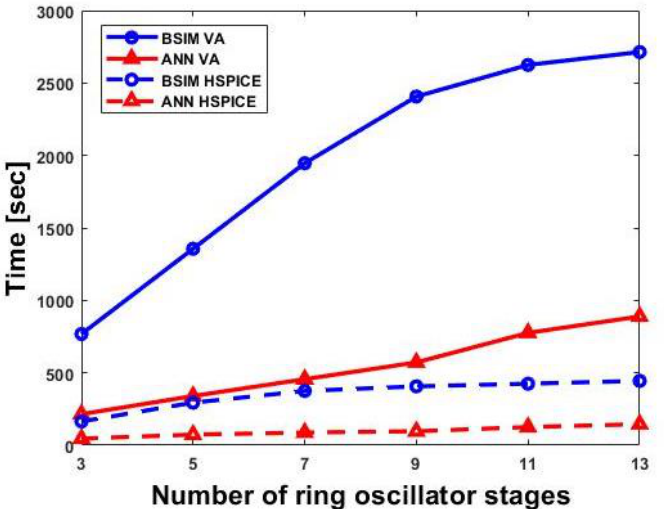
Figure 13. Time comparison of Monte Carlo simulations by stages of a ring oscillator using the single-device